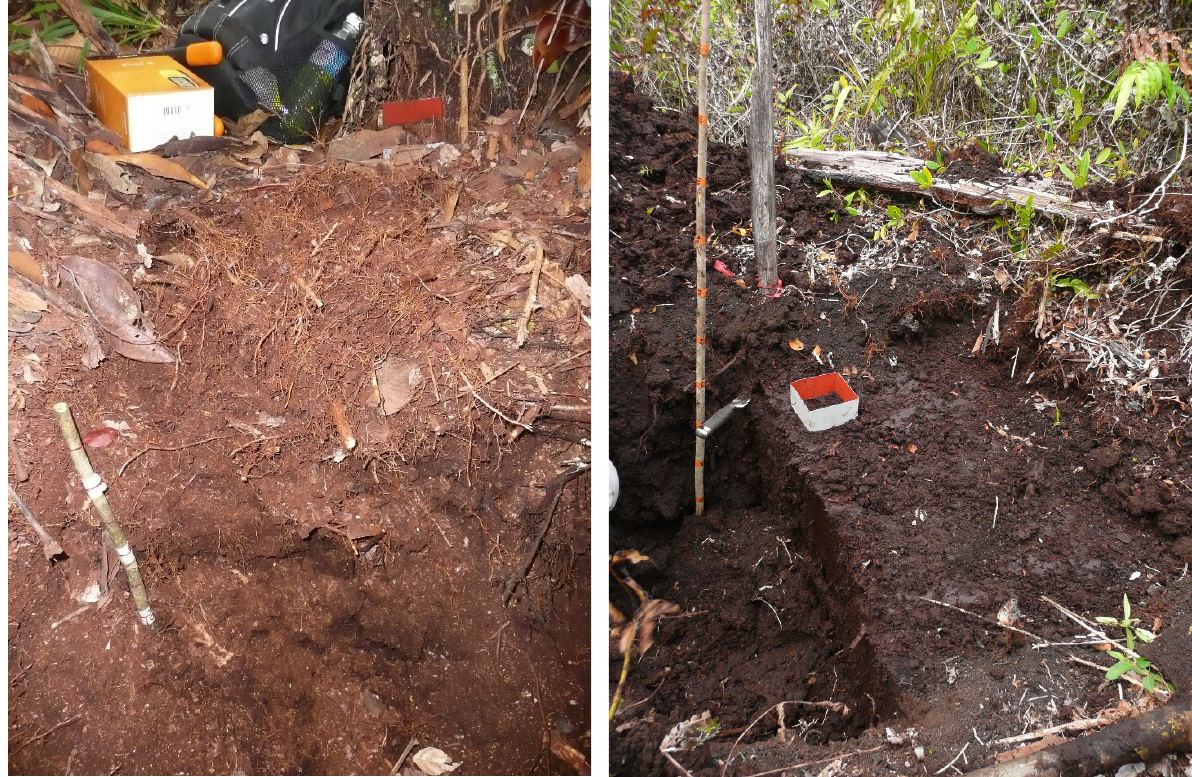
Figure 1. Surface peat in peat swamp forest (left) and in degraded burned peatland (right) in Central Kalimantan. Photos: Jyrki